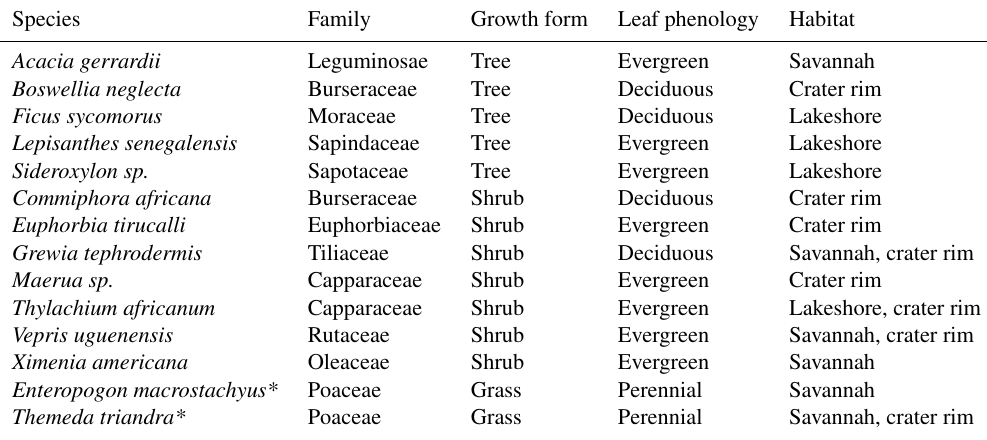
Table 1. Studied plant species and family with their respective growth form, leaf phenology and habitat. Species